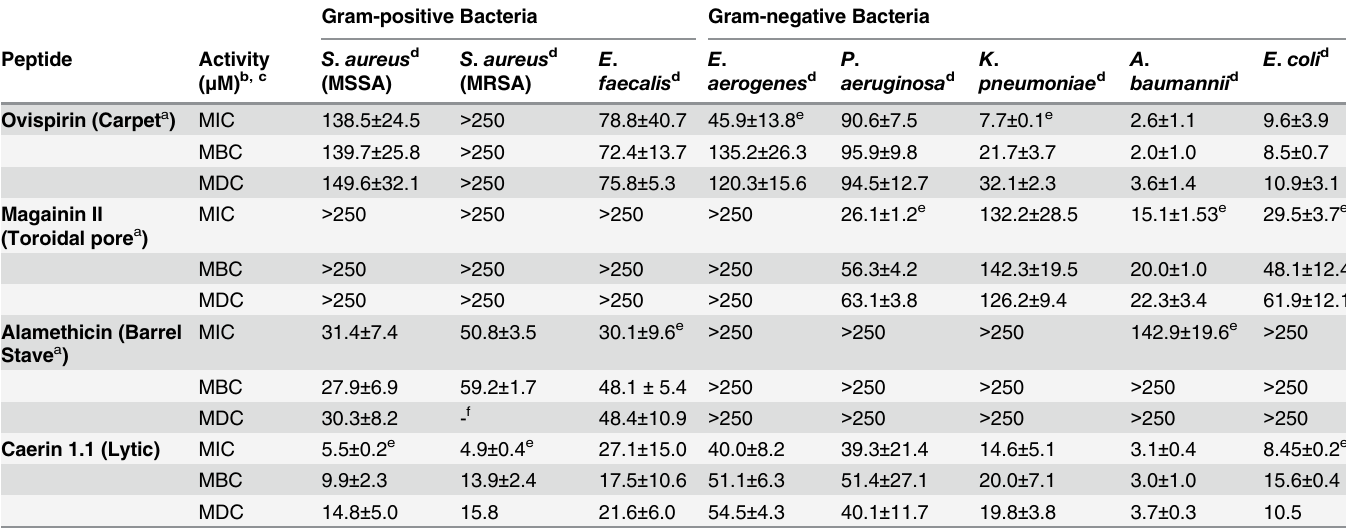
Table 2. Comparison of the antimicrobial activity of three defined pore forming peptides and a membrane lytic peptide determined by microdilu- tion growth assay (MIC), colony count assay (MBC) and the flow cytometry assay (MDC) for Gram positive and Gram negative